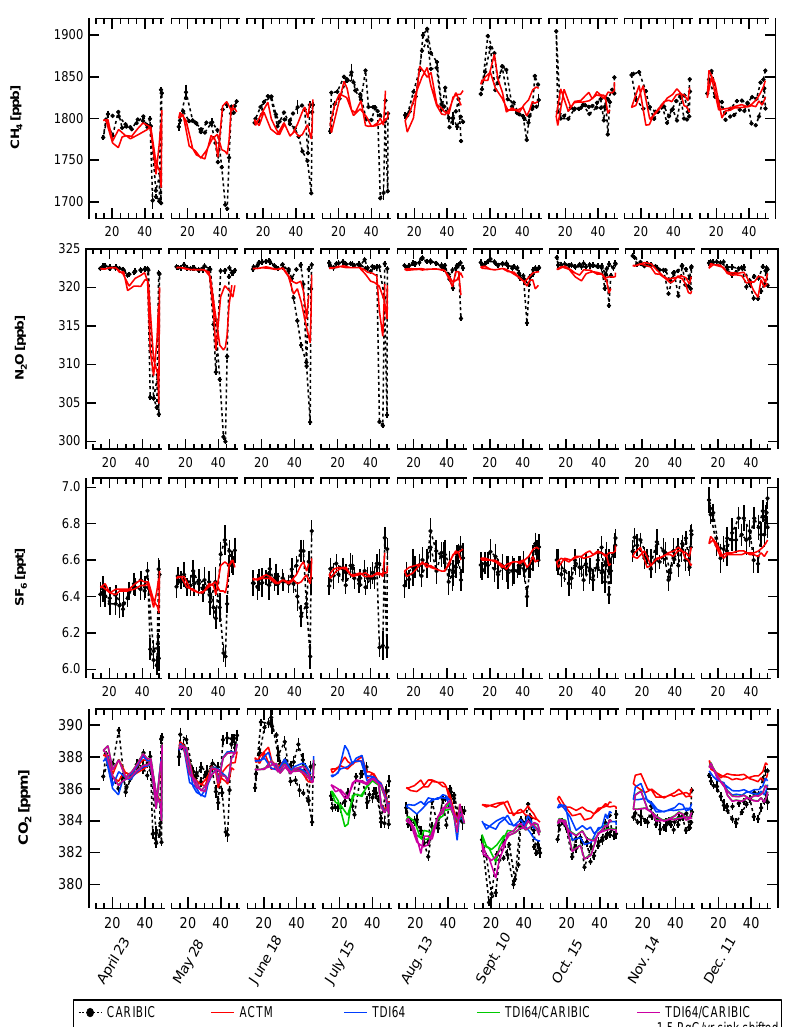
Fig. 1. Comparison between ACTM simulated concentrations and CARIBIC observations for CH 4 , N 2 O, SF 6 and CO 2 for April– December 2008. The x-axis is a time series of latitudinal profiles. Samples collected during outward bound flights (FRA-MAA) and return flights (MAA-FRA) are arranged by latitude for different months. Low N 2 O and SF 6 indicate stratospheric air (stratospheric air being older has lower concentrations and N 2 O has a stratospheric sink). Low CH 4 also indicates stratospheric air mainly due to chemical loss in absence of sources. SF 6 and CH 4 are very useful for validating convective transport in ACTM as they both have basically only continental surface sources. Four cases of CO 2 simulations are produced by combining fossil fuel emission distribution and inverse model fluxes from TDI22 (ACTM) or 3 cases of TDI64 (as discussed